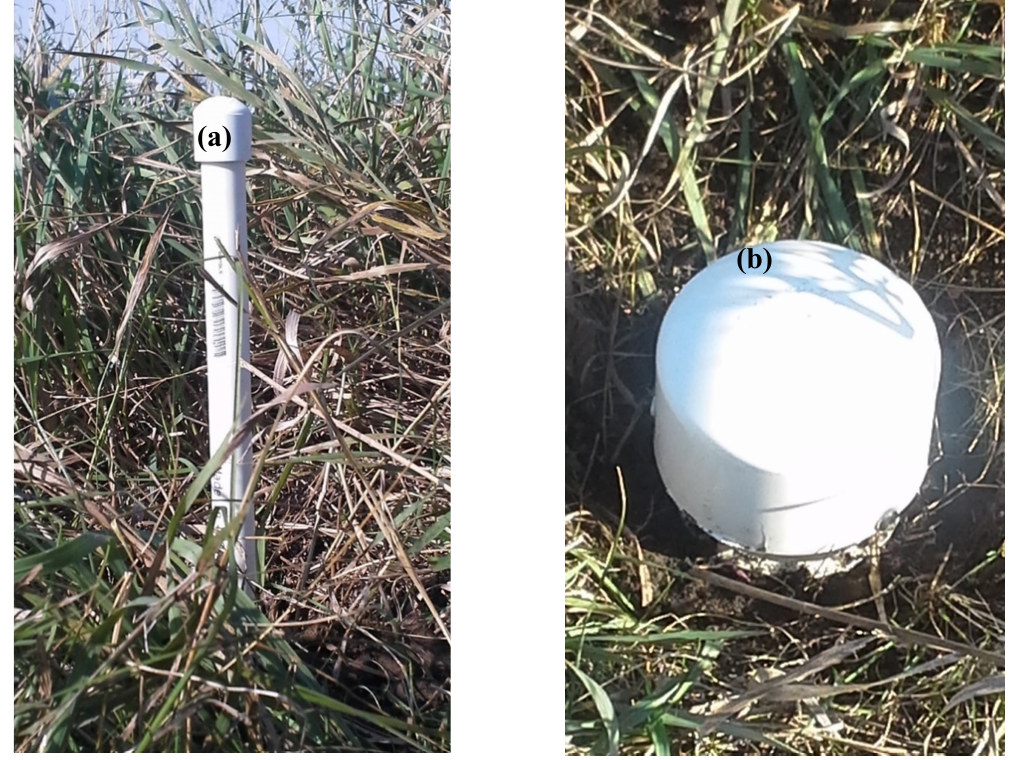
Figure 2. Leachate sampling well in roadside ditches ( a ) during installation and ( b ) after installation.